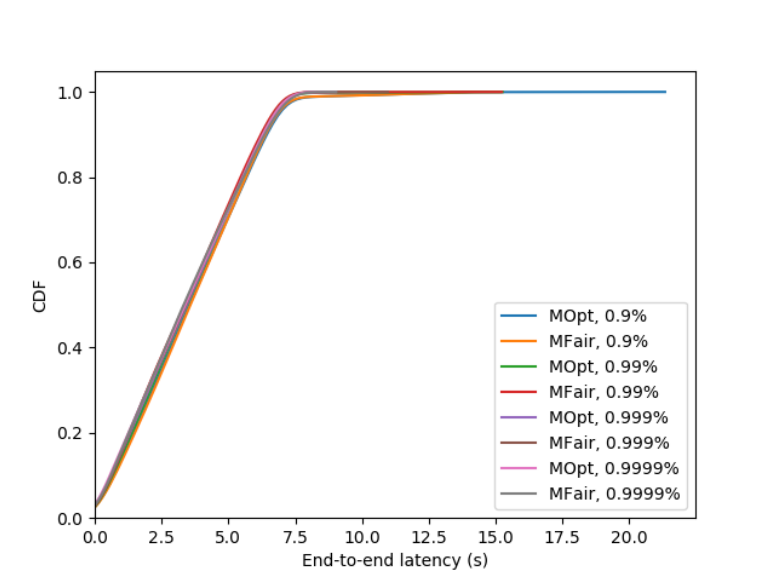
Figure 10. Cumulative distribution function of the end-to-end latency with MFair and MOpt .